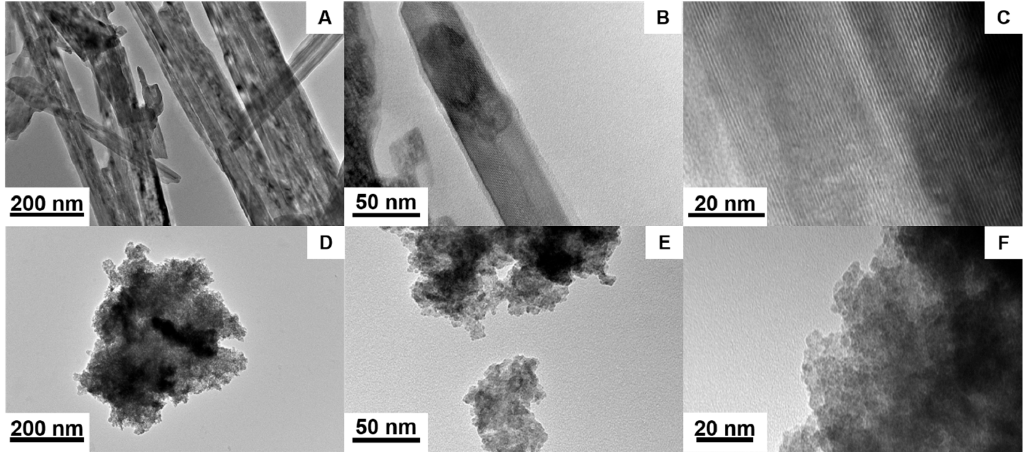
Figure 7. TEM images of the ( A – C ) NiMoO 4 and ( D – F ) NiWO 4 samples.